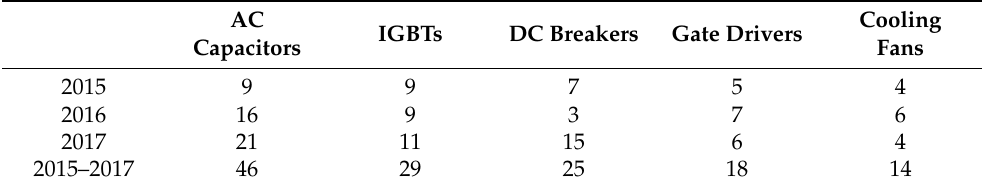
Table 3. Number of failures per year of the components for the 132 inverters in the PhotoVoltaic (PV) plant.